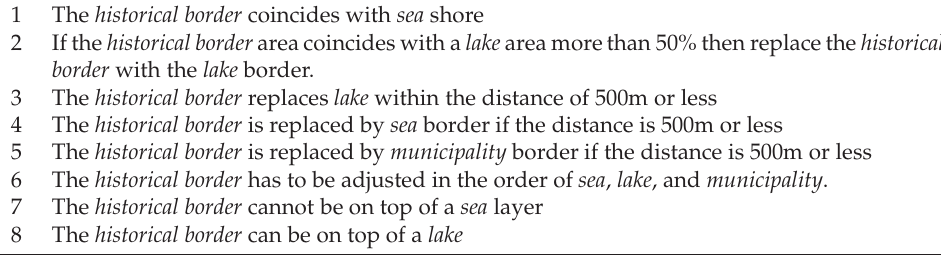
Table 1: The rules for integrating the historical borders in the